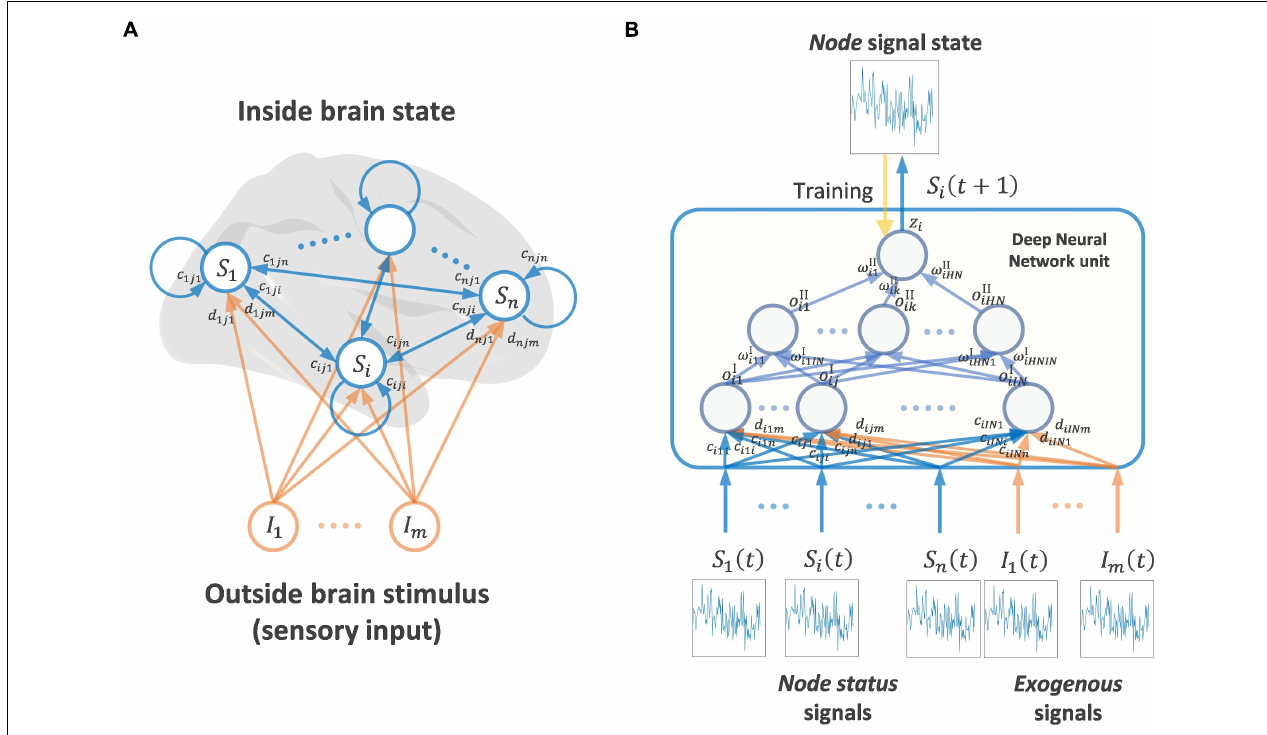
FIGURE 1 | (A) Whole brain node state network and stimulus coming from outside brain (mainly sensory input) (B) Showing signaling framework of one node state. A Deep Neural Network node receives the signal state of other brain nodes and exogenous signals (outside brain stimulus). A DNN unit calculates one output signal, in this case the next time step of the signal state of a node. The DNN unit is trained by teacher signals and the input of other node states and exogenous signals.